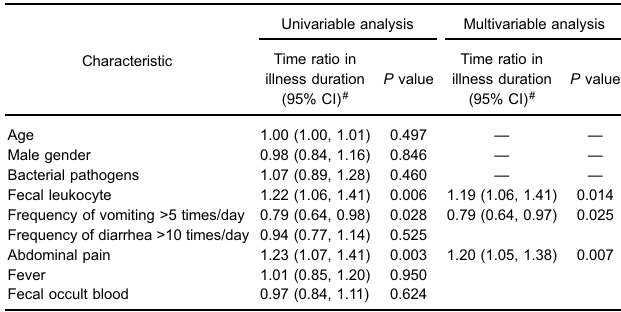
CI, con fi dence interval. # The corresponding regression coef fi cients in the above models can be obtained by taking the logarithm of time